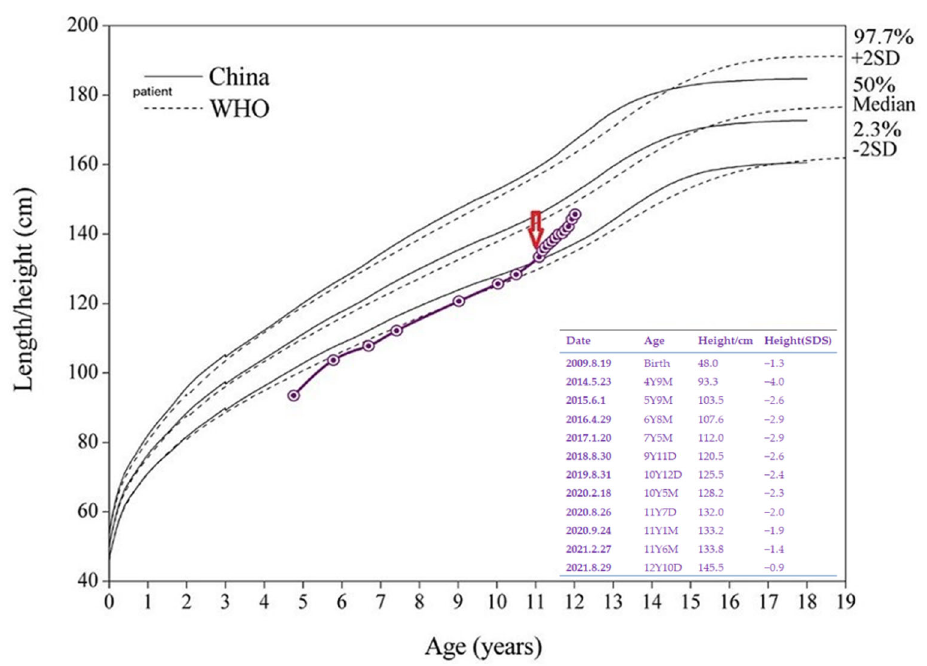
Figure 4. The anthropometric data before and after starting rhGH therapy. The arrows in the growth charts represent the initiation of growth hormone therapy.